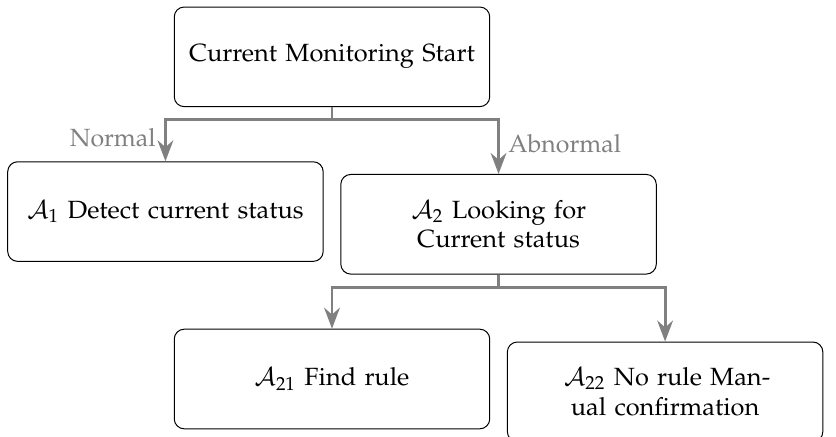
Figure 1. Algorithms for current and equipment status monitoring.